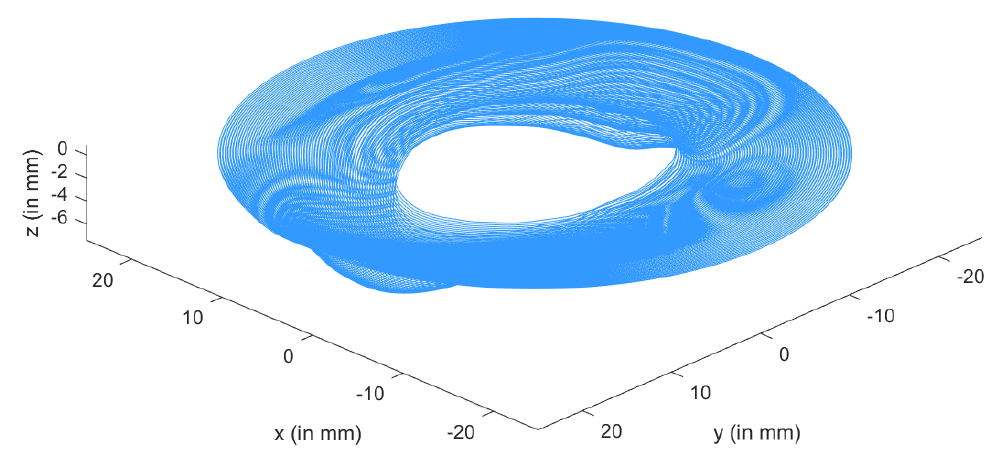
Figure 8. Tool trajectory—three